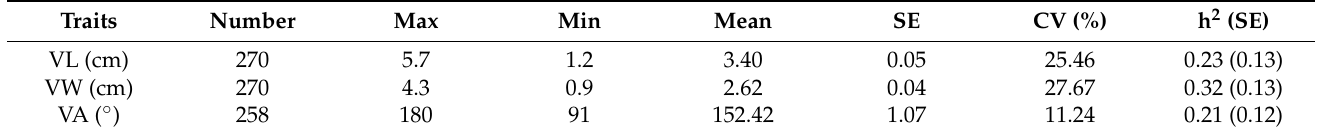
Table 2. Descriptive statistics and heritability of phenotypic data in Suhuai